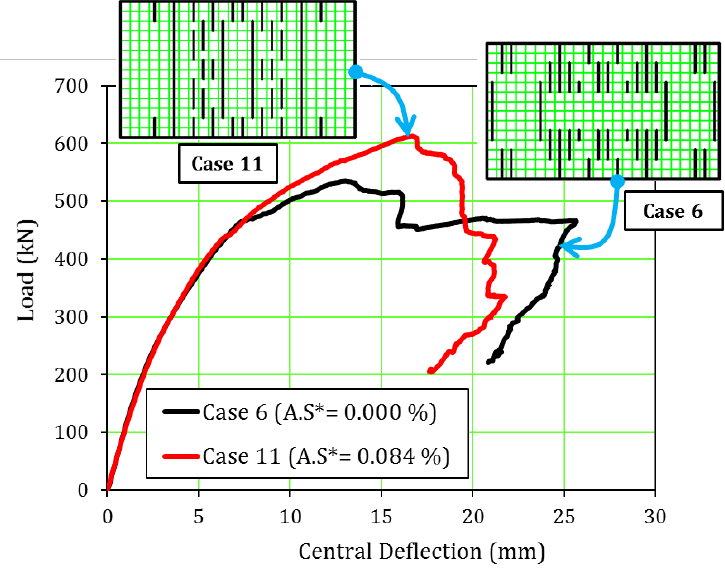
Figure 21. Central deflection of the RC deck and the static load for crack patterns (6 and 11).